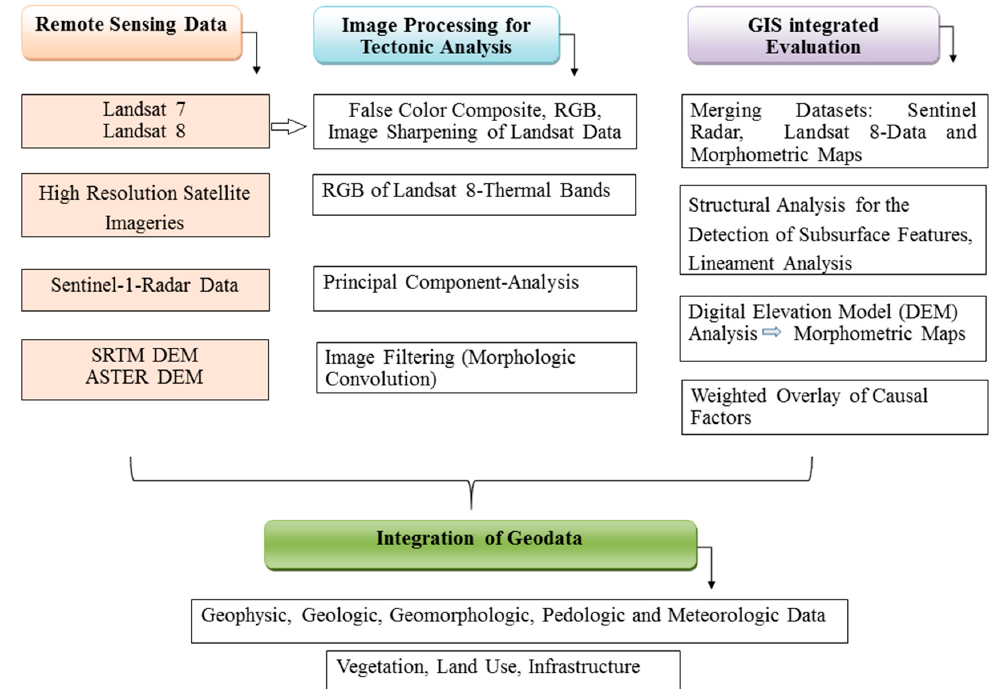
Figure 6. Workflow for gaining the information of tectonic patterns and local site conditions in the case of stronger